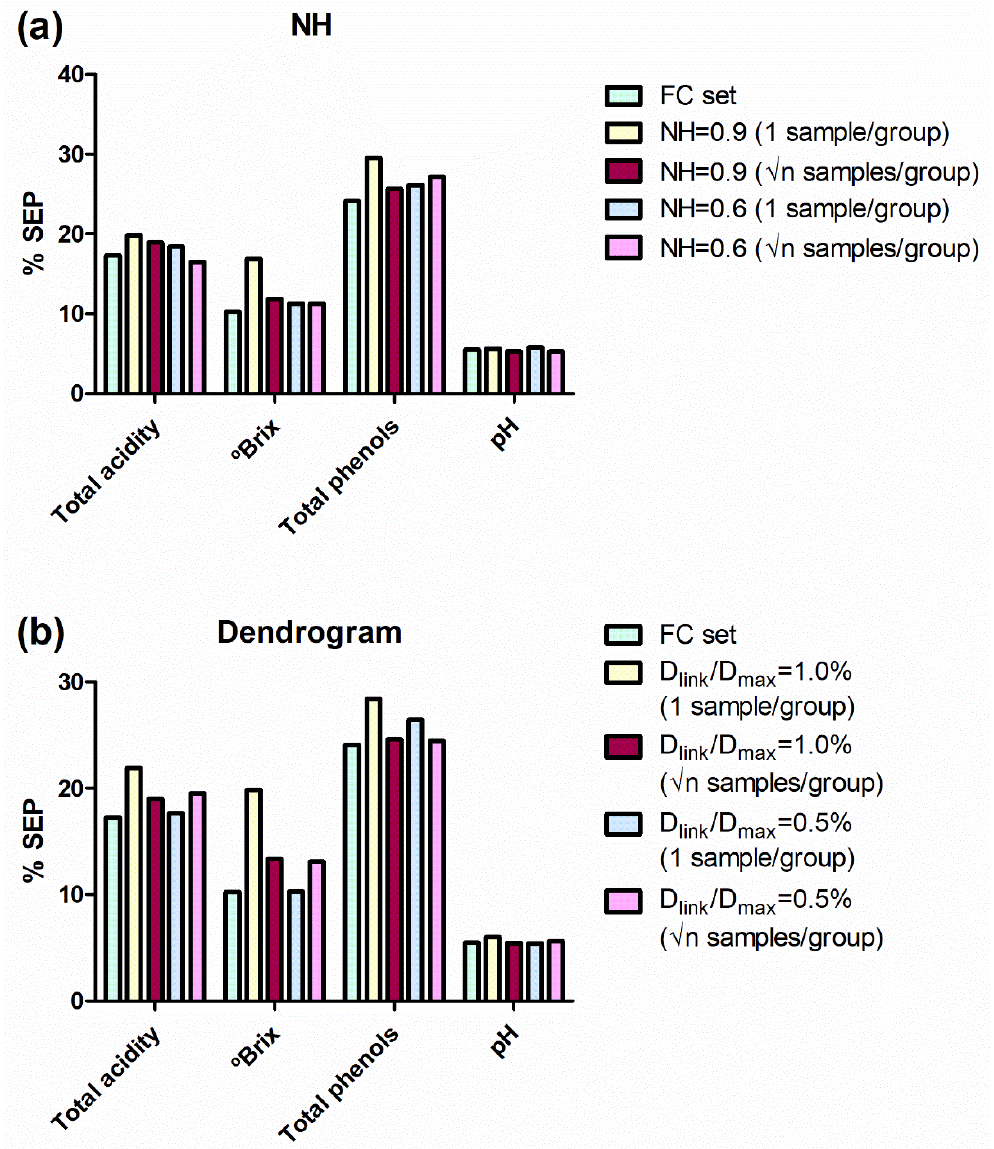
Figure 3. SEP in external validation for the models developed for all the reference parameters and for all the sample sets. SEP values are expressed as percentages taking into account the applicability range of their respective models. ( a ) Comparison for NH sample selection. ( b ) Comparison for Hierarchical Clustering (dendrogram) sample selection. SEP: standard errors of prediction; NH: Neighbourhood Mahalanobis distance; FC, full calibration; D link : different linkage distances; D max : the maximum linkage distance; √n: square root of the number of samples in a group.